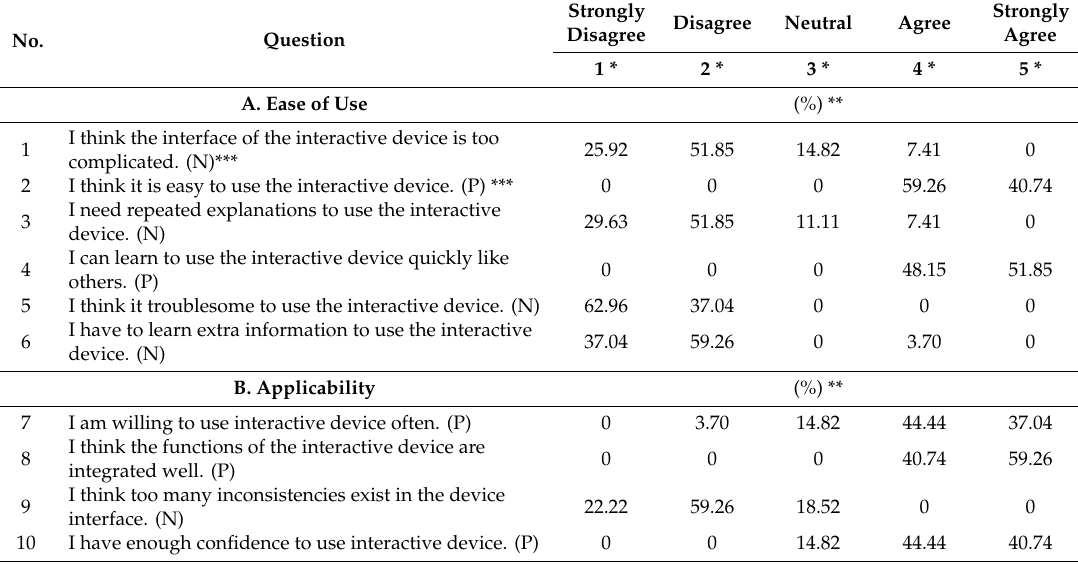
Table A1. Questions about system usability in the questionnaire and statistics of percentages of the scores of the answers to the